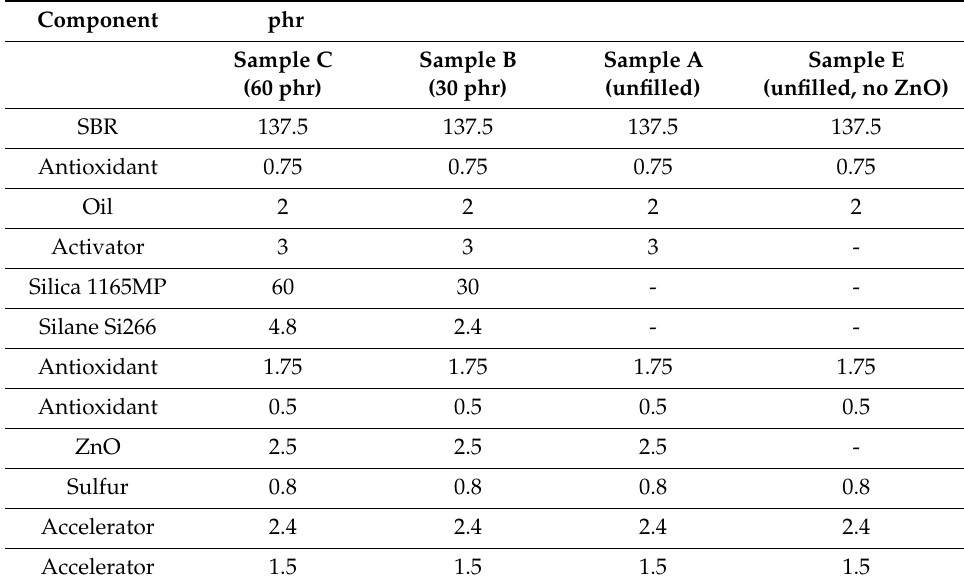
Table 1. Composition of investigated samples. From left to right column the complexity is decreased. The compositions are given in parts per 100 g rubber (phr).